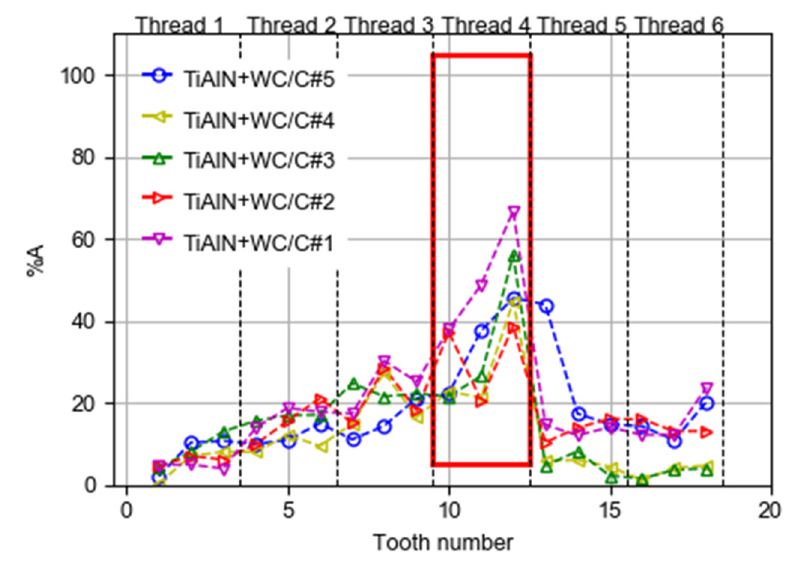
Figure 18. Evolution of %A parameter on the teeth of every TiAlN+WC/C coated taps.